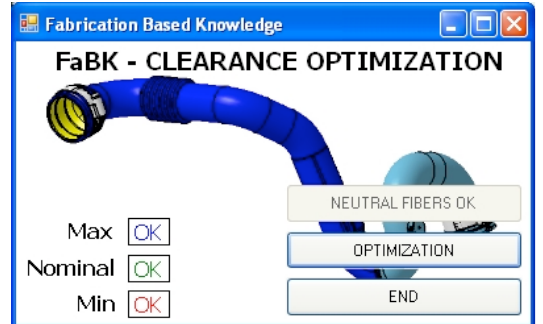
Fig. 2 . FaBK CATIA optimization